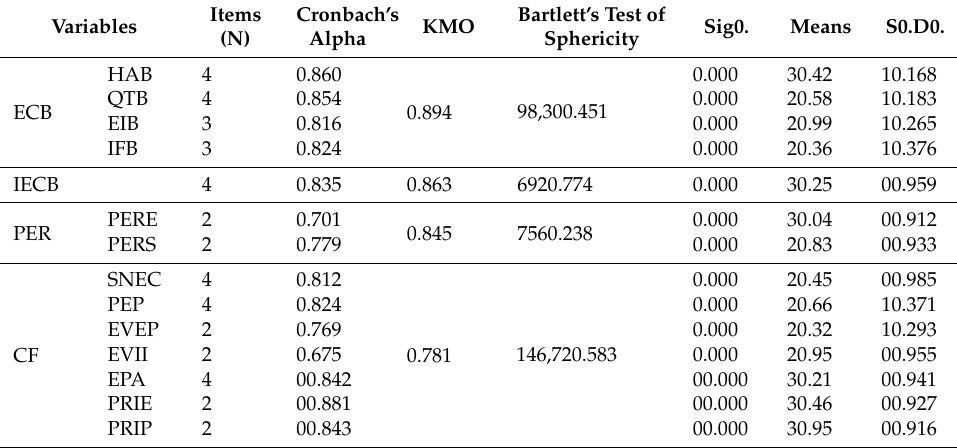
Table 3. Results of scales test and descriptive statistics